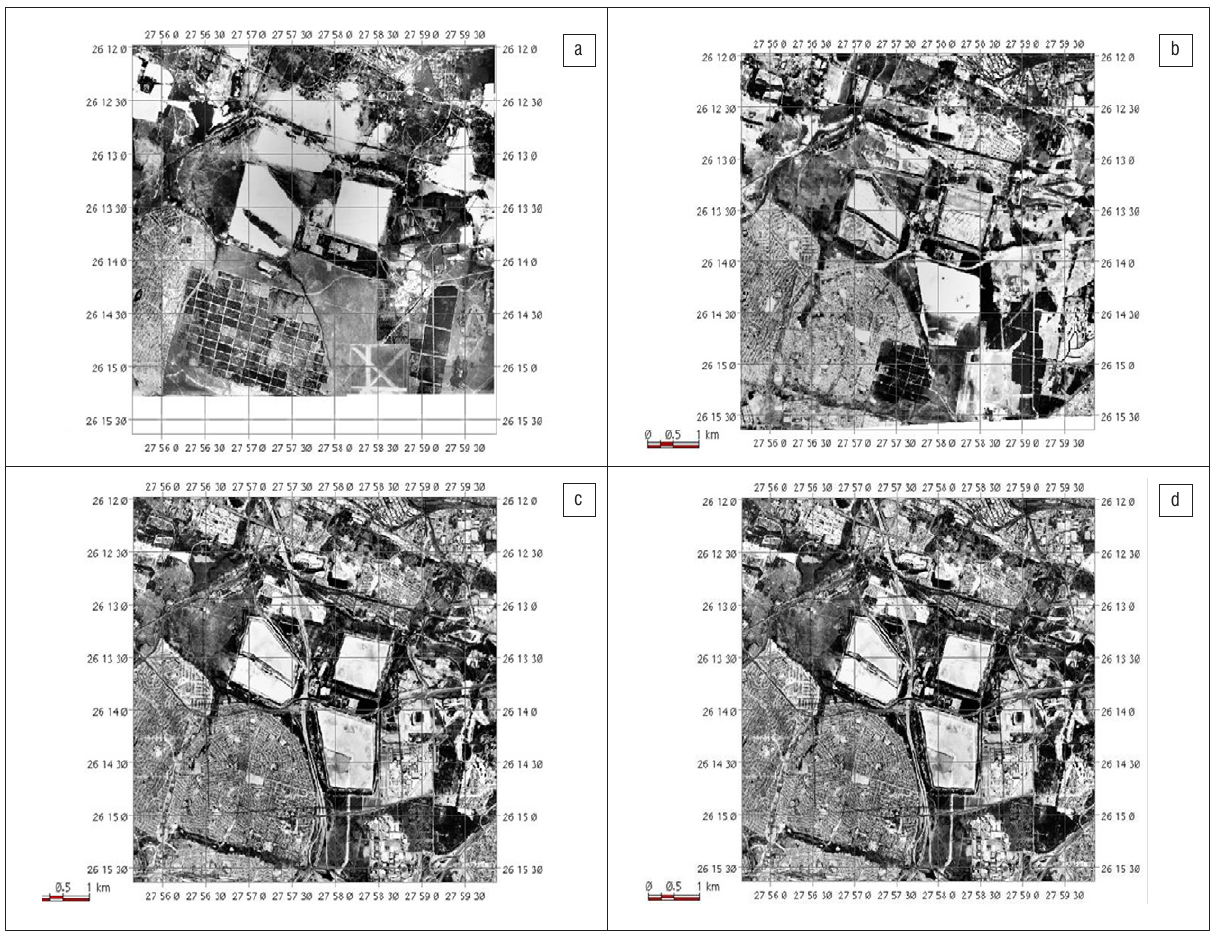
Figure 2: Aerial photograph of the Crown Gold Recoveries tailings complex for (a) 1952, (b) 1976, (c) 1991 and (d)